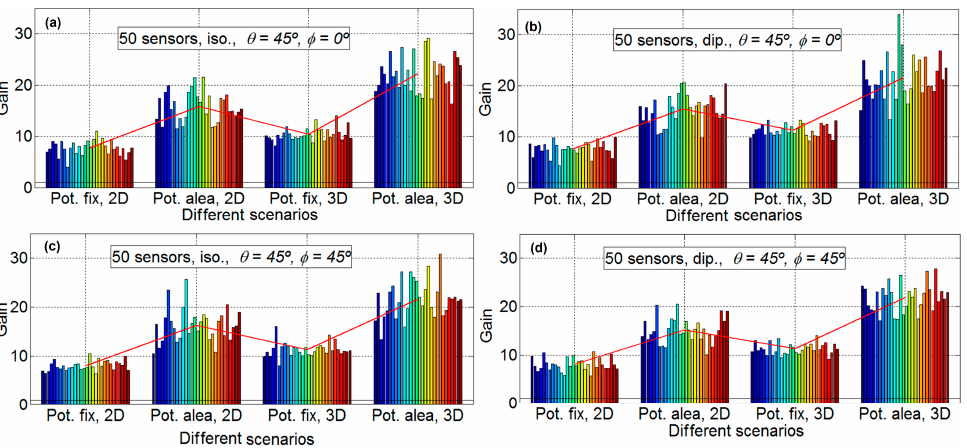
Figure 6. Gain results for 50 sensors. Isotropic ideal antenna, φ = 0 ◦ and θ = 45 ◦ in subfigure ( a ) ( upper left ), dipole antenna, φ = 0 ◦ and θ = 45 ◦ in subfigure ( b ) ( upper right ), isotropic ideal antenna, φ = 45 ◦ and θ = 45 ◦ in subfigure ( c ), ( lower left ) and dipole antenna, φ = 45 ◦ and θ = 45 ◦ in subfigure ( d ) ( lower right ).